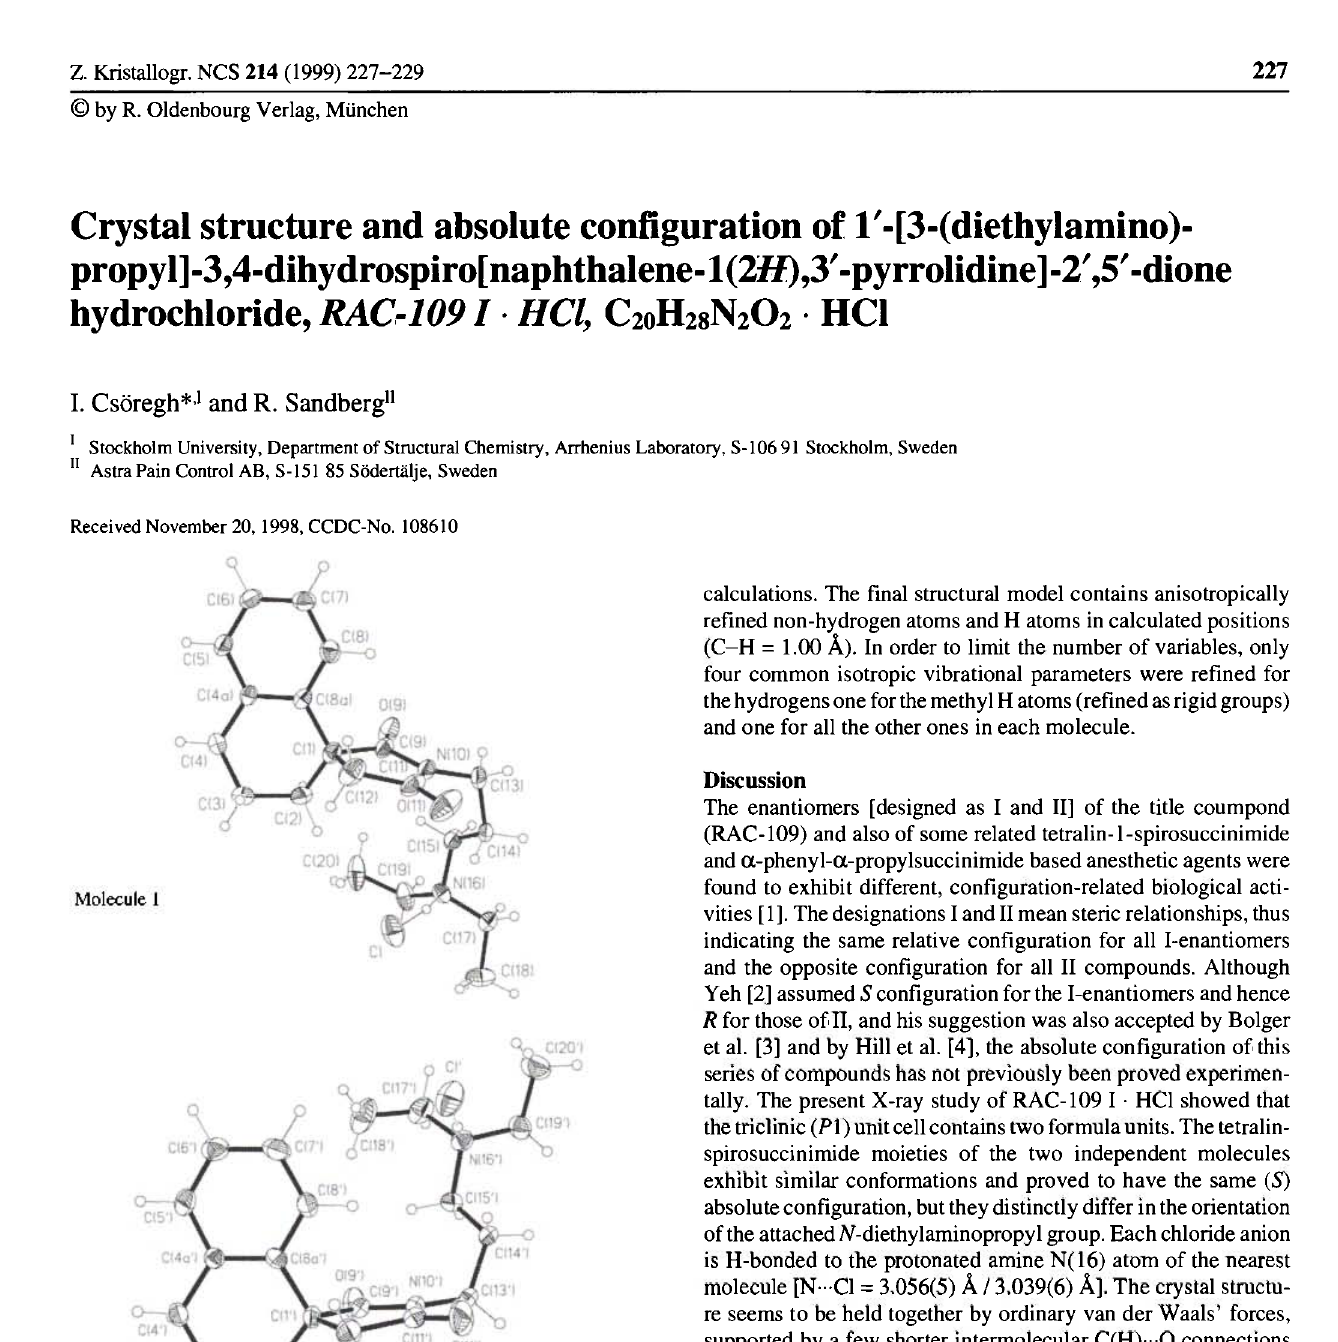
Table 1. Data collection and